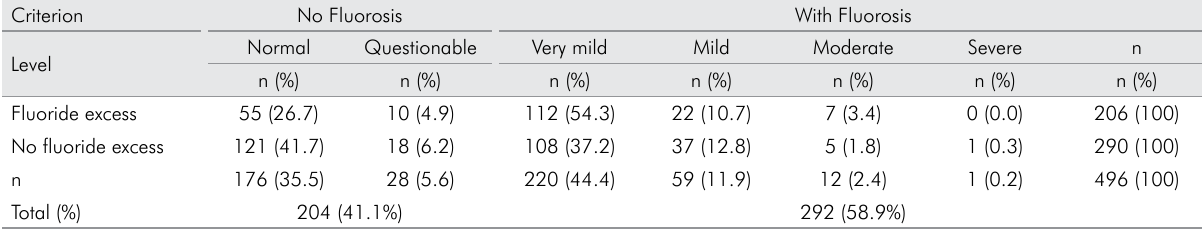
Table 3. Distribution of numerical and percentage values of the 496 twelve-year-old children examined, according to area with and without excess fluorine and level of fluorosis. Birigui, SP, Brazil,